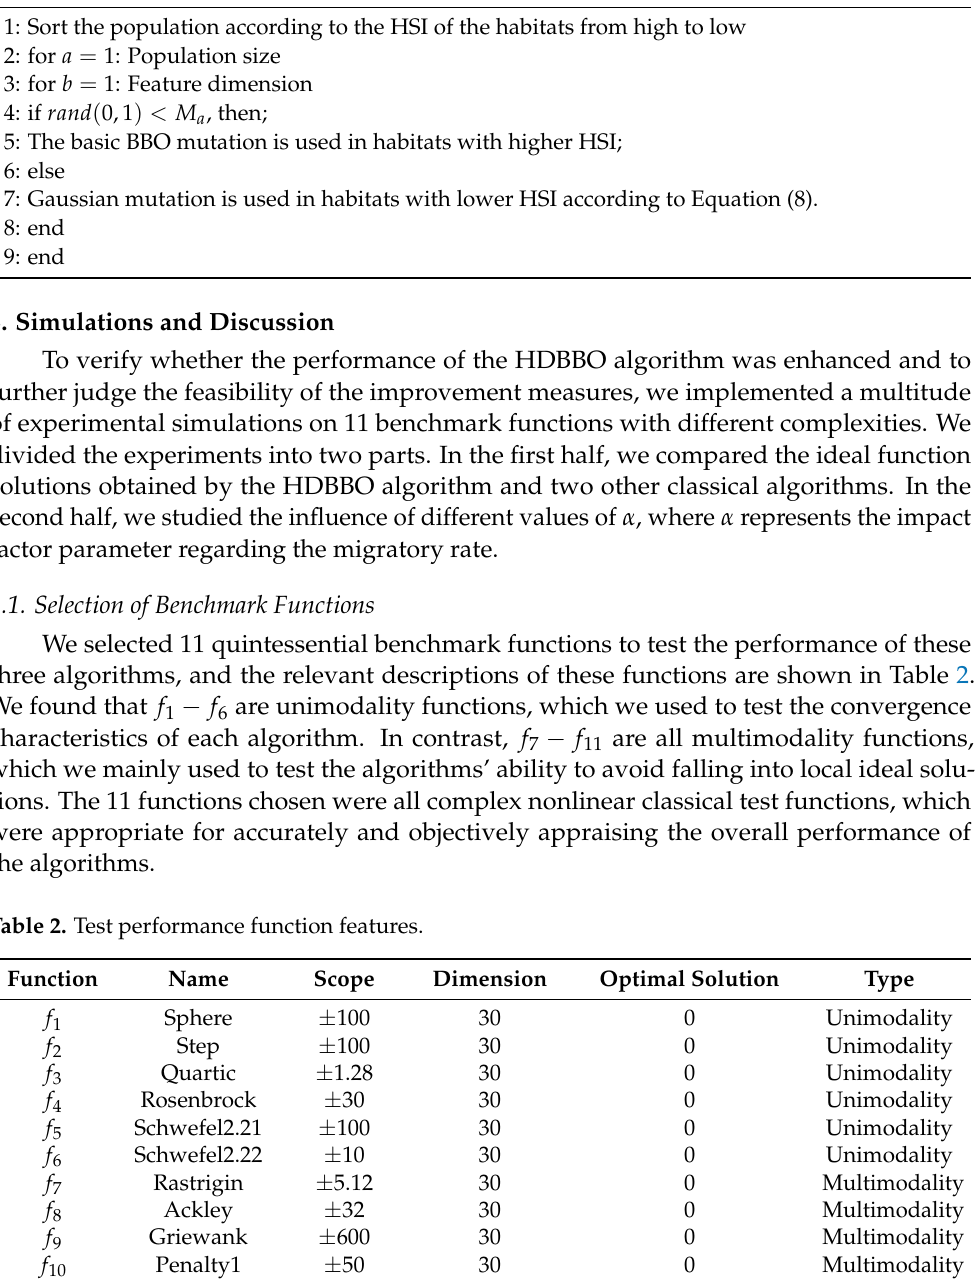
Algorithm 2 Dual-mode Mutation Operation